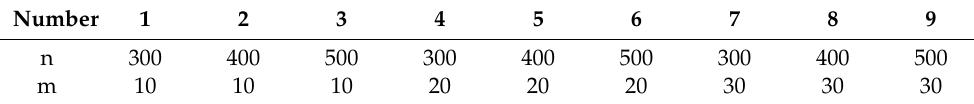
Table 5. Task size.